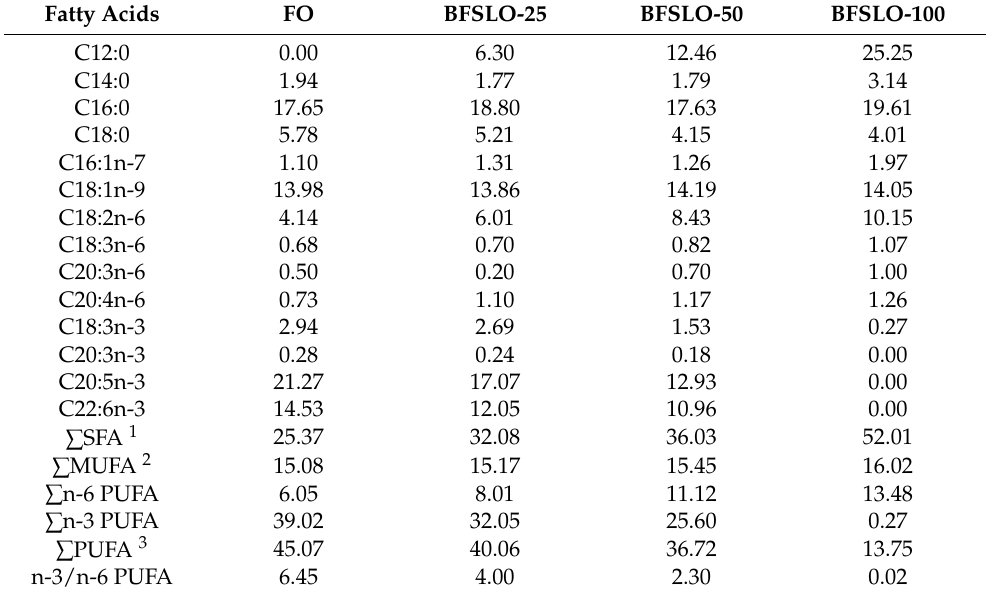
Table 2. Fatty acid composition (mg/g) of the four experimental diets with different gradient levels of BSFLO (25%, 50% and 100%) replacing FO (control). Fatty Acids FO BFSLO-25